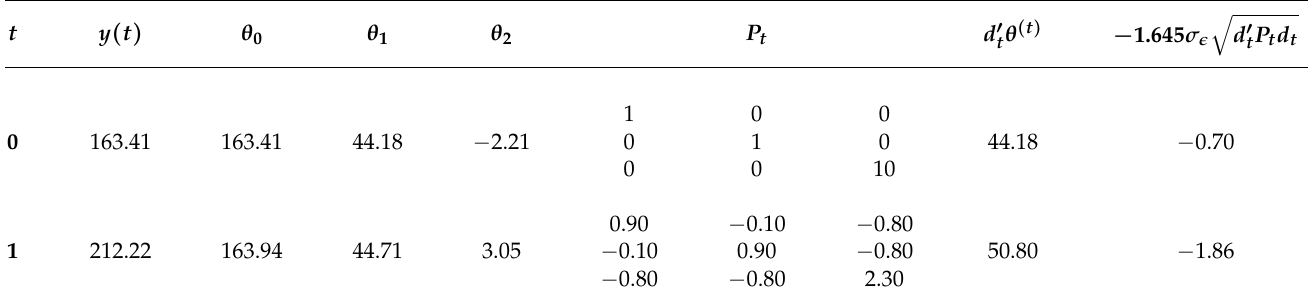
Table 10. Recursive procedure of θ i and P t when t < N −